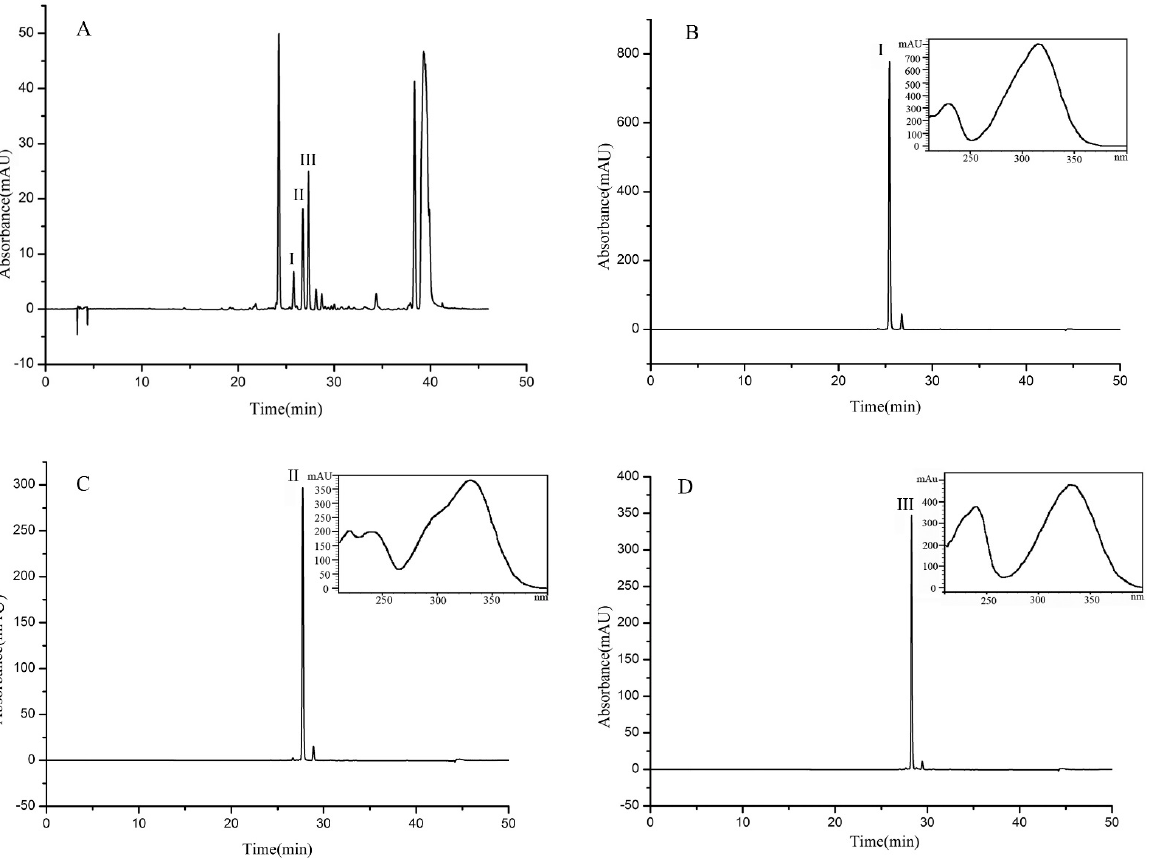
Figure 4. HPLC chromatogram of the extract from UPE ( A ) and HPLC chromatograms and UV spectra of compounds Ι ( B ), II ( C ), and ΙΙΙ ( D ) separated and purified by HSCCC.